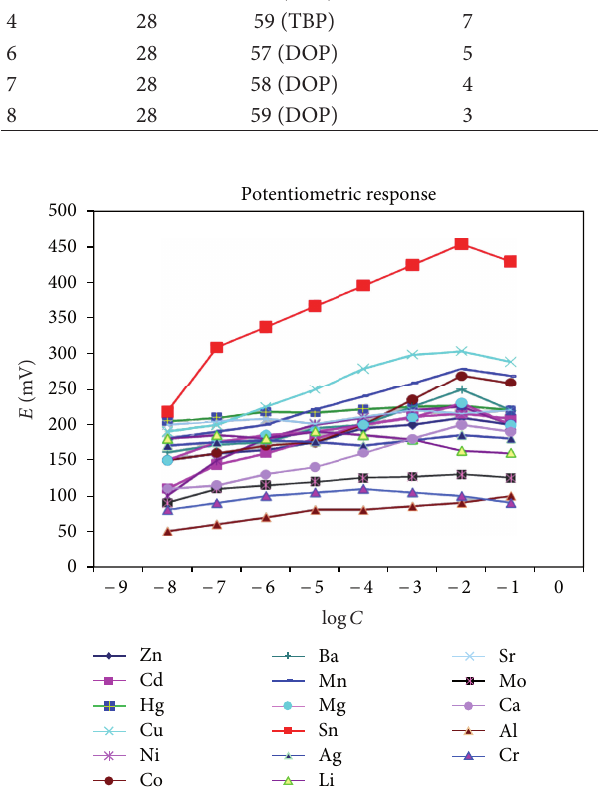
F 2: Potential response of various ion-selective electrodes based on STSC.